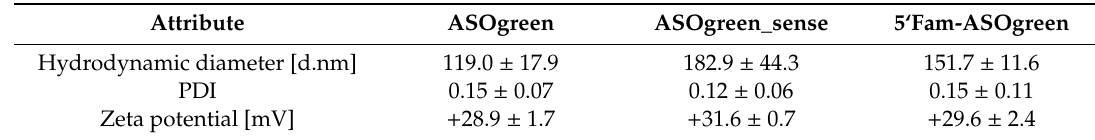
Table 3. Physicochemical properties of CS–ASO prototype nanocomplexes at a P / N charge ratio of 90 prepared with 85 mM NaCl.